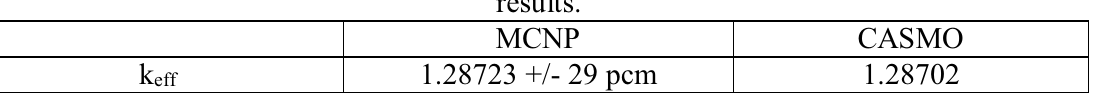
Table III. Multiplication coefficient for UOX/MOX core with Hf rods: MCNP and